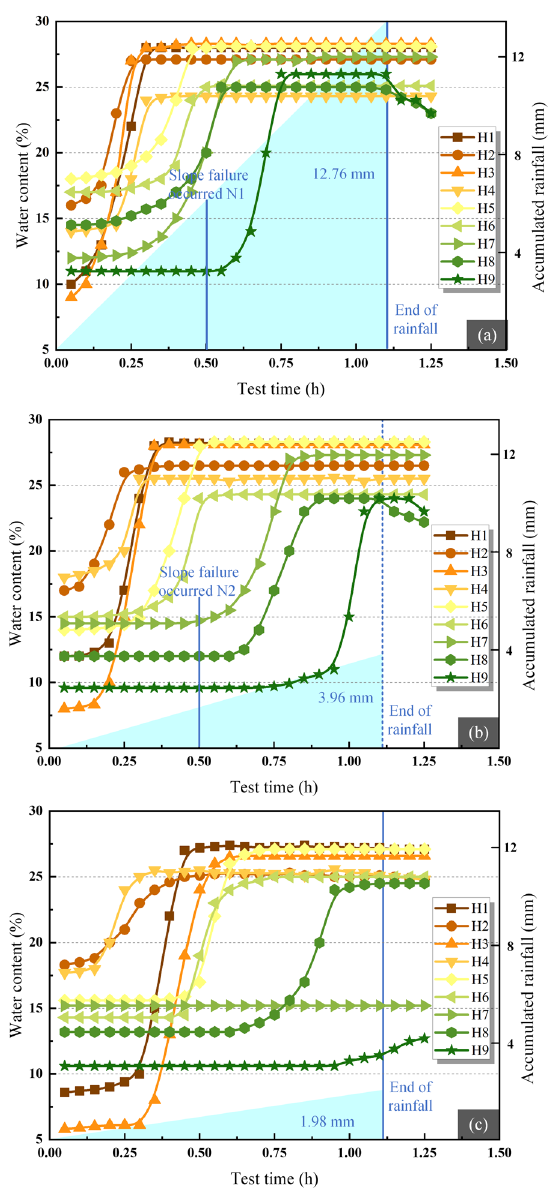
Fig. 13 Time history chart of water content change under different rainfall intensity a N1, b N2, c N3